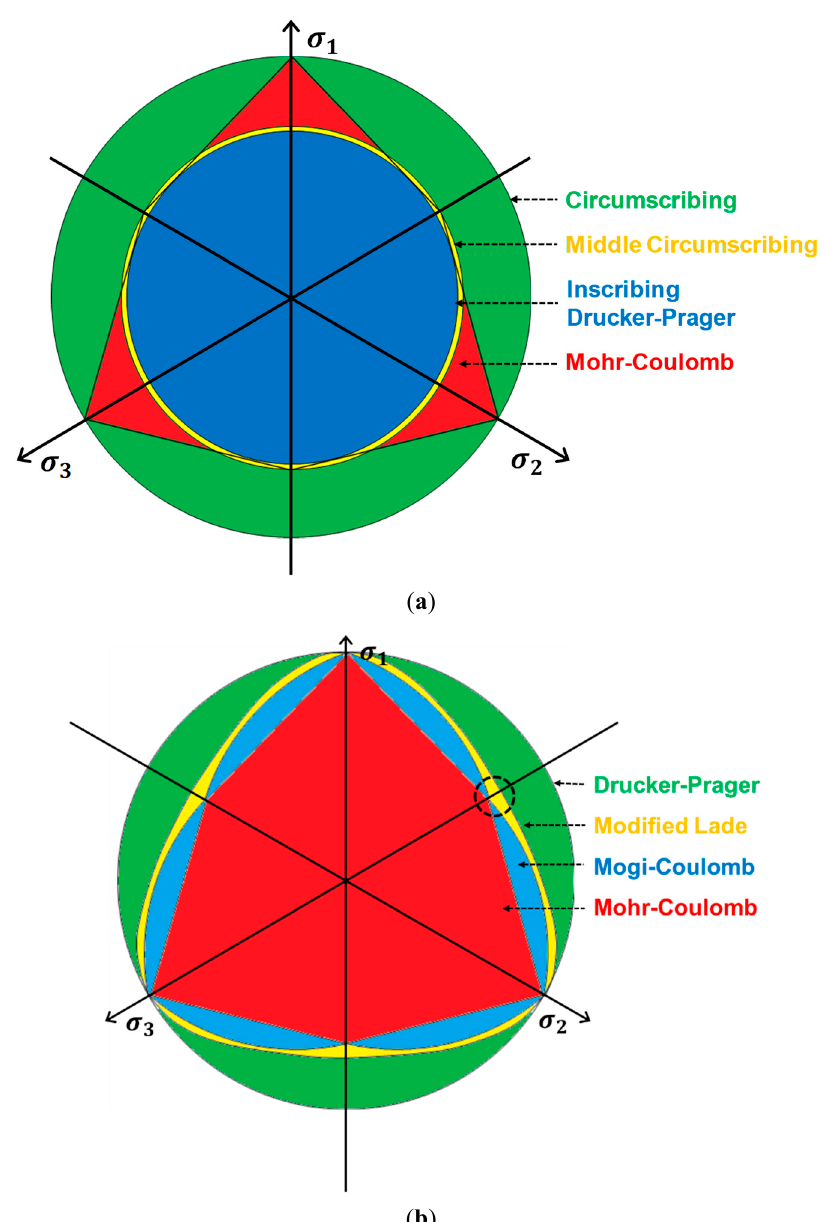
Figure 1. ( a ) Failure surfaces in π -plane calculated by the Drucker–Prager and Mohr–Coulomb failure criteria. The Drucker–Prager constants were determined with the assumptions that the failure surface circumscribes (green), middle circumscribes (yellow) or inscribes (blue) the failure surface of the Mohr–Coulomb (red) criterion. Internal friction angle is 30 ◦ . ( b ) Failure surfaces in π -plane calculated by the Drucker–Prager (circumscribing case, green), modified Lade (yellow), Mogi–Coulomb (blue), and Mohr–Coulomb (red) failure criteria. The dashed black circle represents the stress state where the maximum and intermediate principal stresses are identical. Internal friction angle is 30 ◦ .